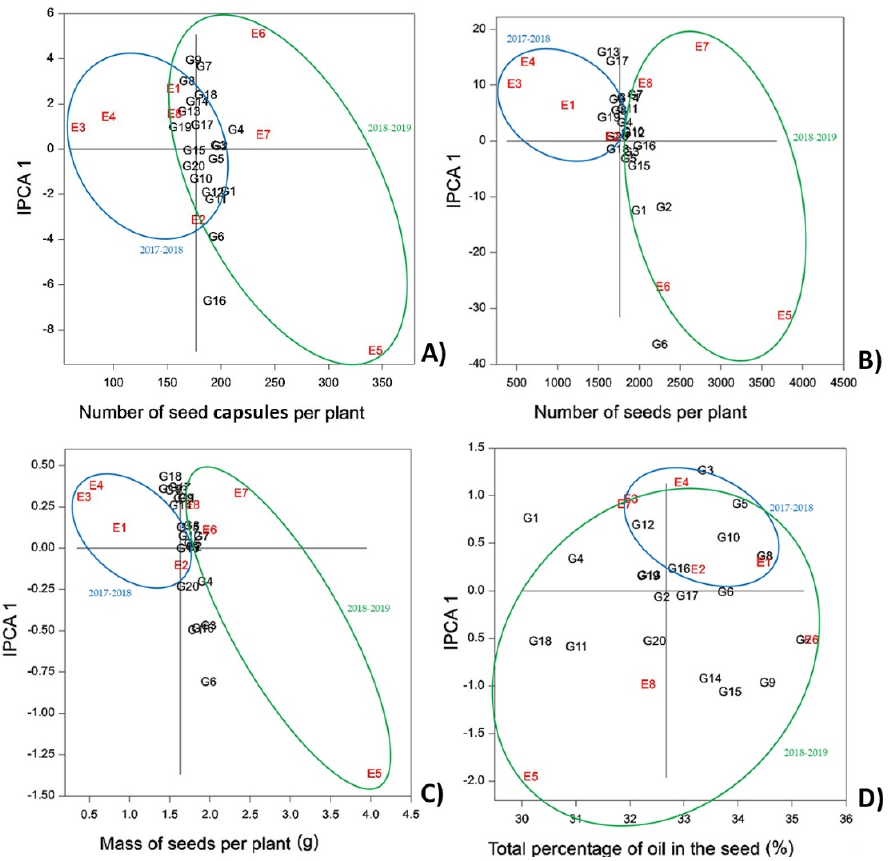
Figure 3. AMMI 1 biplots for ( A ) number of seed capsules per plant (NSCP); ( B ) number of seeds per plant (NSP); ( C ) mass of seeds per plant (MSP); ( D ) total percentage of oil in the seed (TPOS) of 20 camelina accessions across eight experimental environments. E = environment; G = genotype;